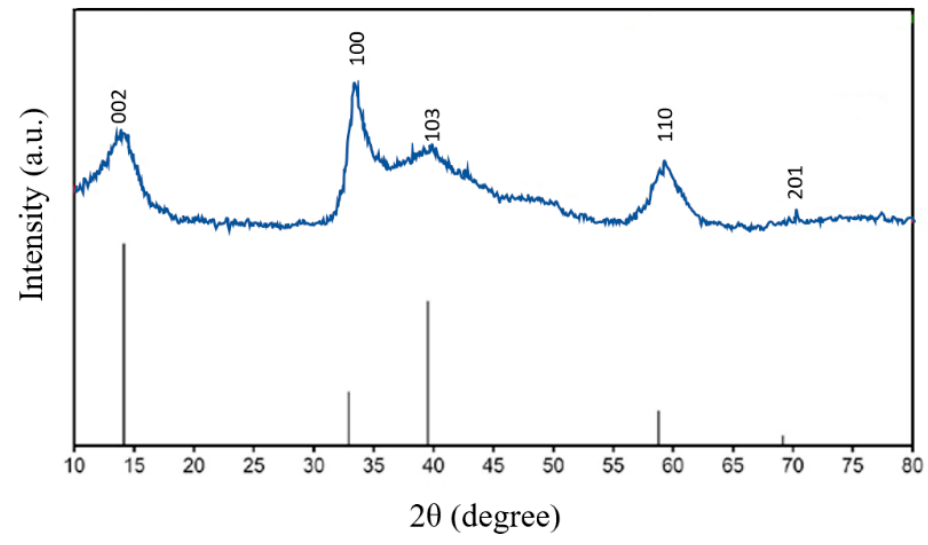
Figure 15. The XRD pattern of the MoS 2 nanoparticles.